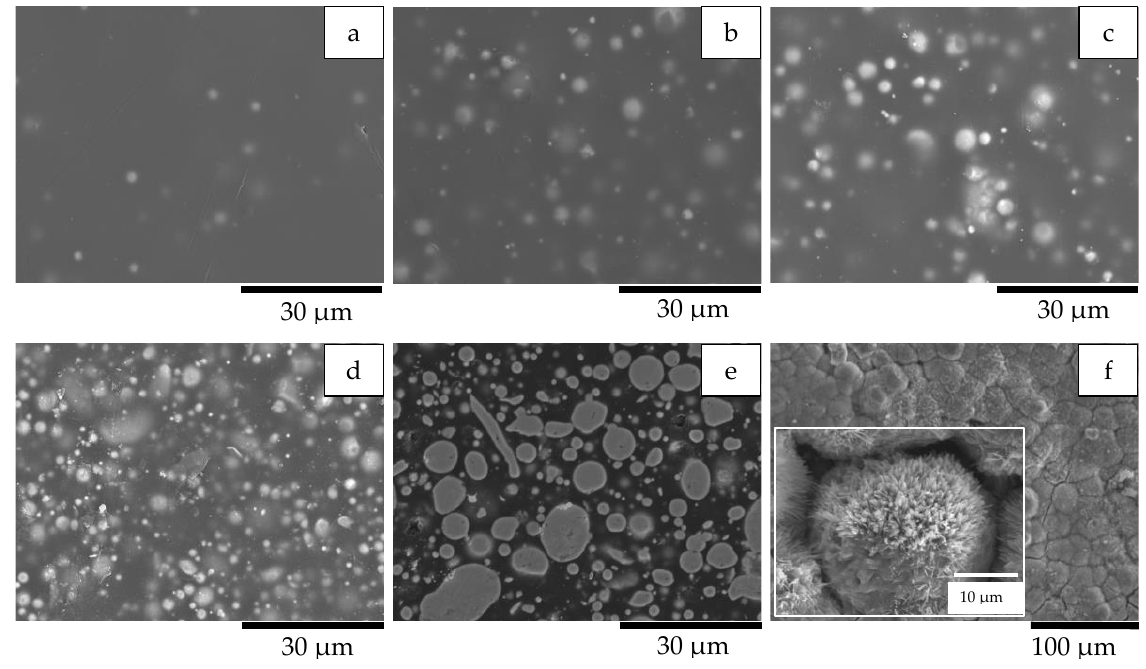
Figure 3. SEM images. ( a – d ) Coating surfaces with 4 zinc dosages; ( e ) cross-section and ( f ) surface after immersion test for a coating prepared from the formula Zn – 80%-PC. ( a ) Zn-20%-PC; ( b ) Zn-40%-PC; ( c ) Zn-60%-PC; ( d ) Zn-80%-PC; ( e ) Zn-80%-PC, after test; ( f ) Zn-80%-PC, after test.